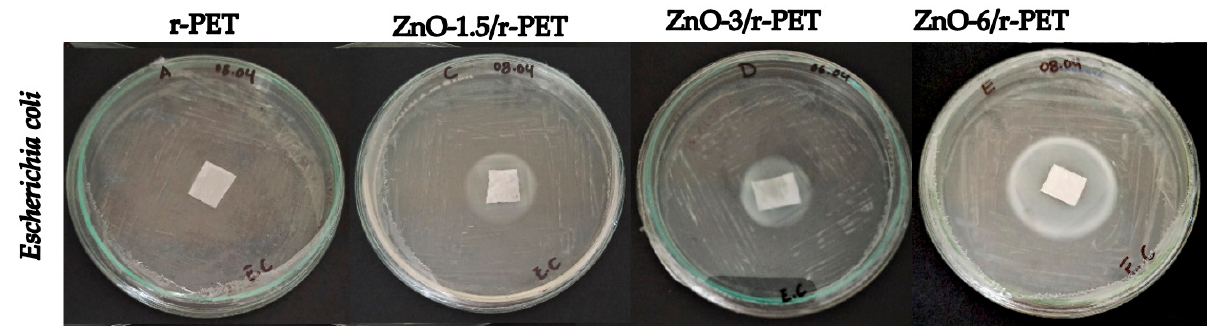
Figure 4. Antibacterial tests Bacillus subtilis in polymer composite fibers.